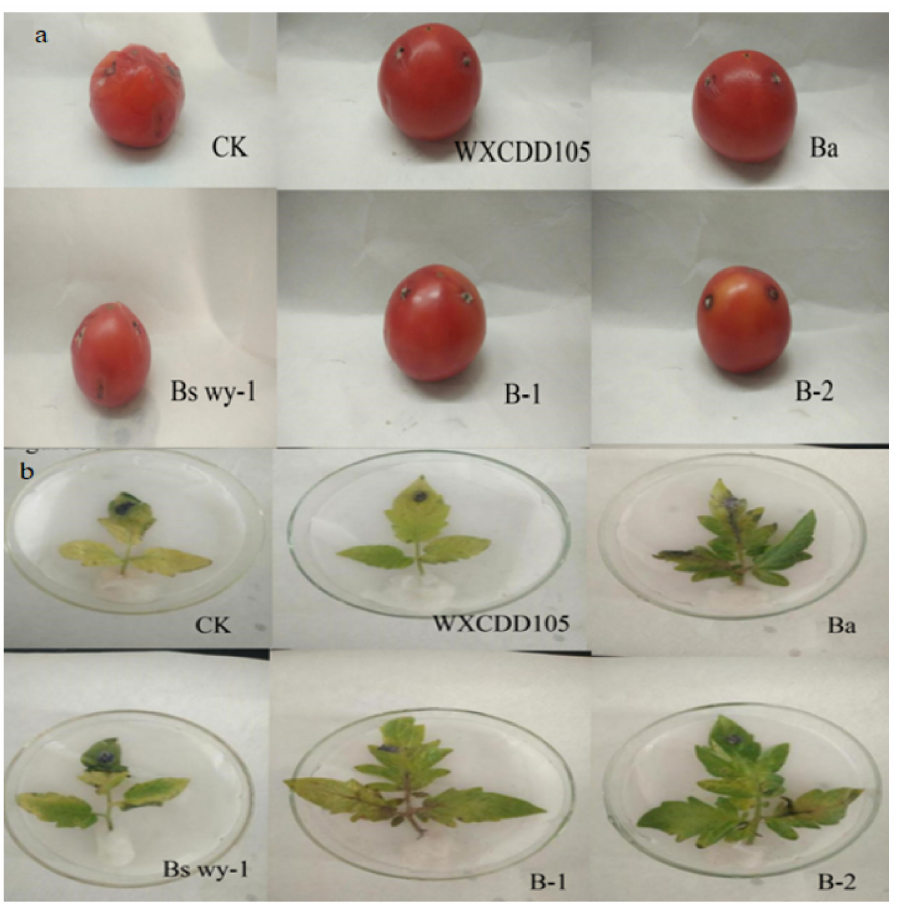
Figure 5. Effects of single and compound strains on the in vitro fruits of tomato gray mold ( a ) and leaf mold ( b